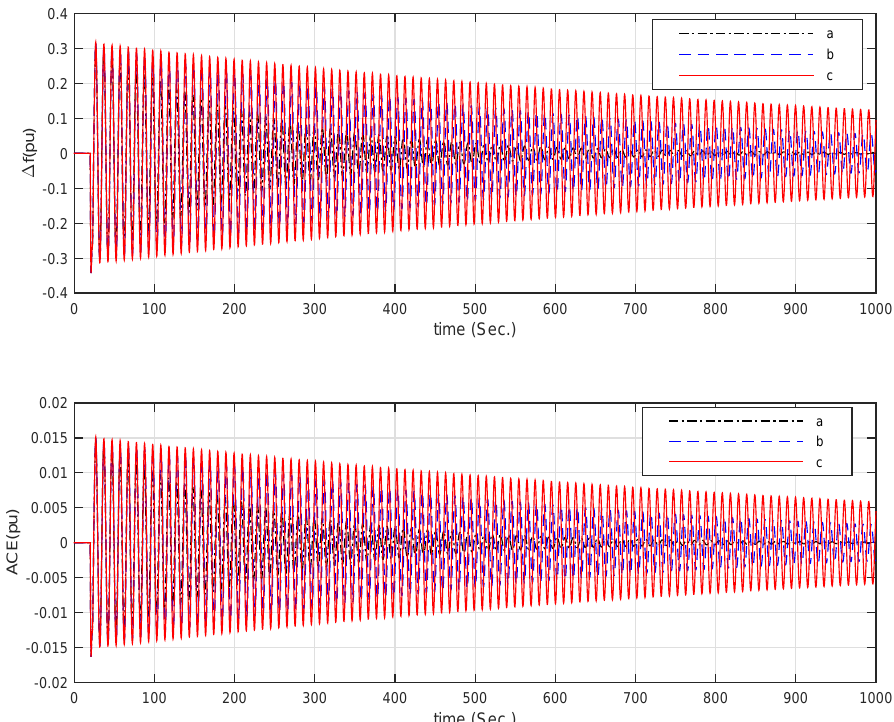
Figure 5. Frequency deviation and control error responses of one-area deregulated LFC scheme with K I = 0.6, h 1 ( t ) = 0 and different K P , h 2 ( t )